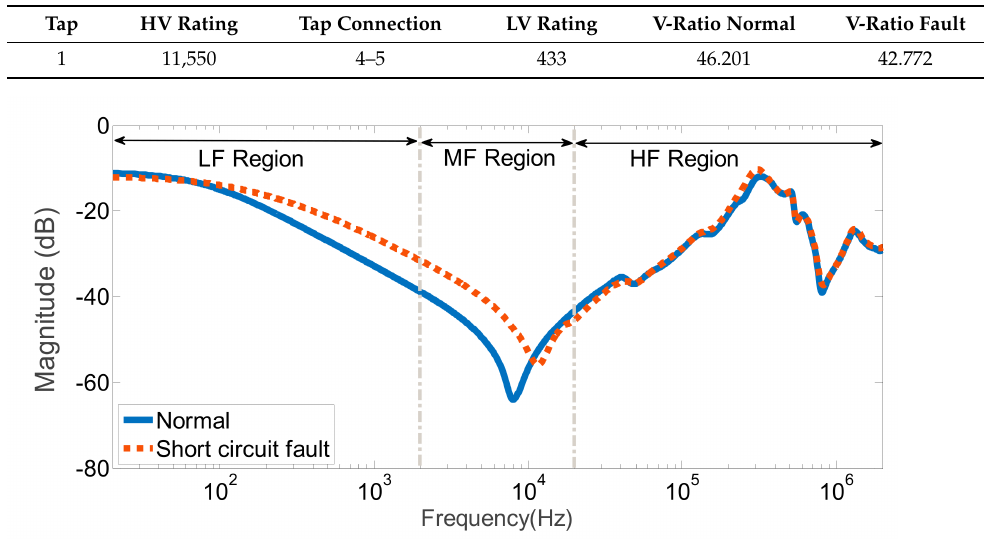
Table 5. Measured V-ratio at normal and faulty conditions.